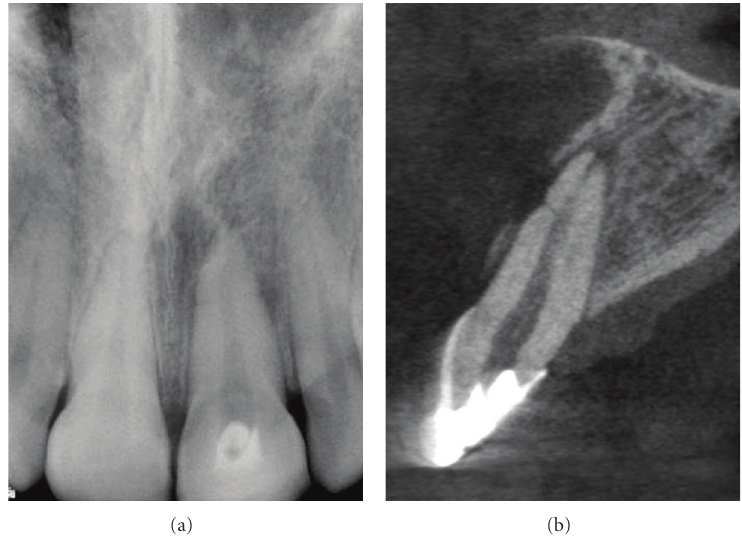
Figure 13: Traumatic injuries to the anterior dentition may result in a horizontal root fracture. Visualizing these fractures with periapical radiographs can be di ffi cult as the beam must be in parallel alignment to the axis of the fracture. Conventional periapical image (a) shows horizontal radiolucent line separating the apical 1/3rd of the root. Note the loss of lamina dura and lateral radiolucency on the distal root surface adjacent to the horizontal radiolucency. Cross-sectional high-resolution (0.076 mm) image showing “V” shaped fracture and minimal displacement of the root segments. Note the loss of buccal cortical plate, widening of the buccal periodontal ligament space and periapical